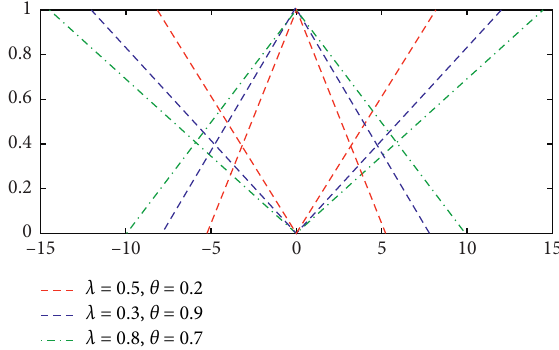
� (− 1 . 25 , 0 , 1 . 25 ; − 3 , 0 , 3 ) . 2